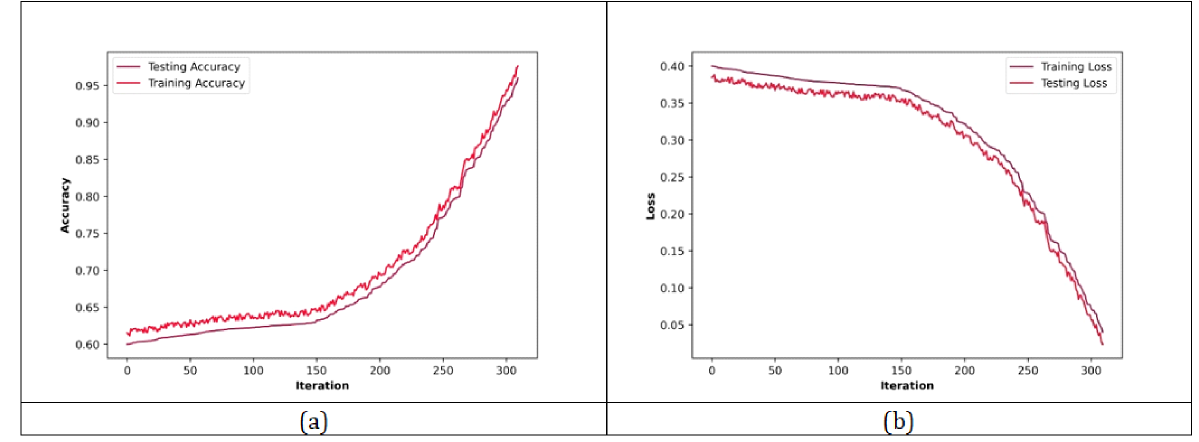
Figure 6. Performance analysis based on ( a ) accuracy and ( b ) loss for Sentiment Classification using Yelp 2014 dataset.